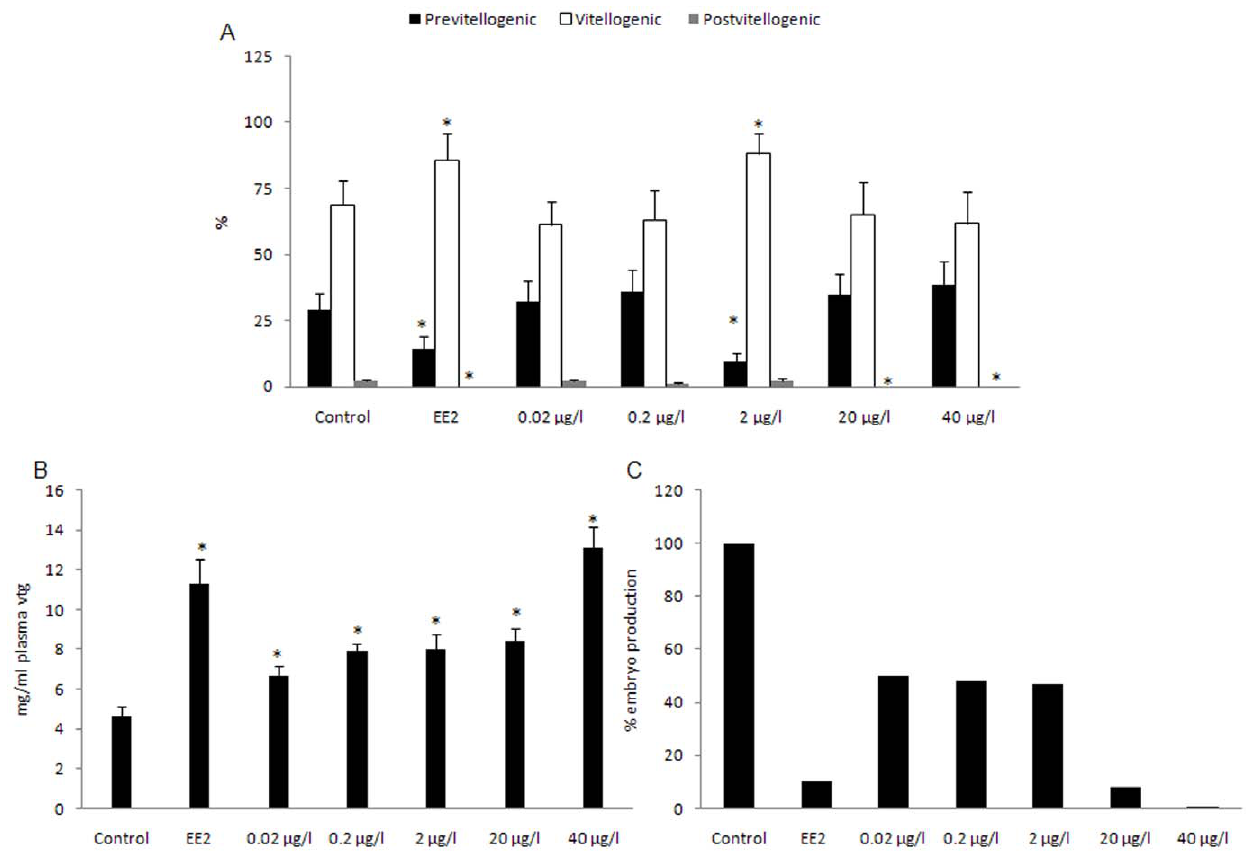
Figure 1. Effects of DEHP exposure in female zebrafish on oocyte growth and embryo production. A, Percentages of pre-vitellogenic, vitellogenic, post-vitellogenic oocytes in female (n=5) exposed to DEHP (0.02, 0.2, 2, 20 and 40 m g/l) or EE2 (25 ng/l). Asterisks* indicate statistical significant differences set at P , 0.05. Data were shown as mean 6 SEM. B, Increase of plasma vitellogenin levels in female zebrafish (n=3) exposed to DEHP (0.02, 0.2, 2, 20 and 40 m g/l) or EE2 (25 ng/l). Data were shown as mean 6 SD. Asterisks* indicate statistical significant differences compare to control group (p , 0.05). C, Reduction of total embryos in female zebrafish exposed to (0.02, 0.2, 2, 20 and 40 m g/l) DEHP or EE2 (25 ng/l).